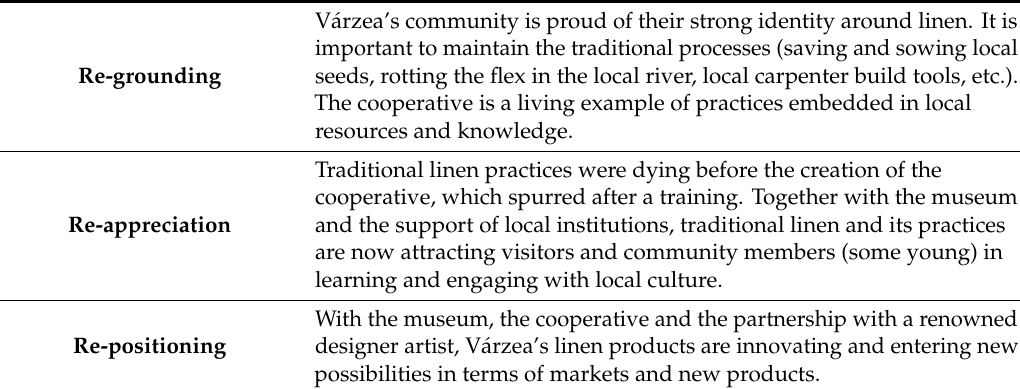
Table 1. Summary of sustainable place-shaping practices in V á